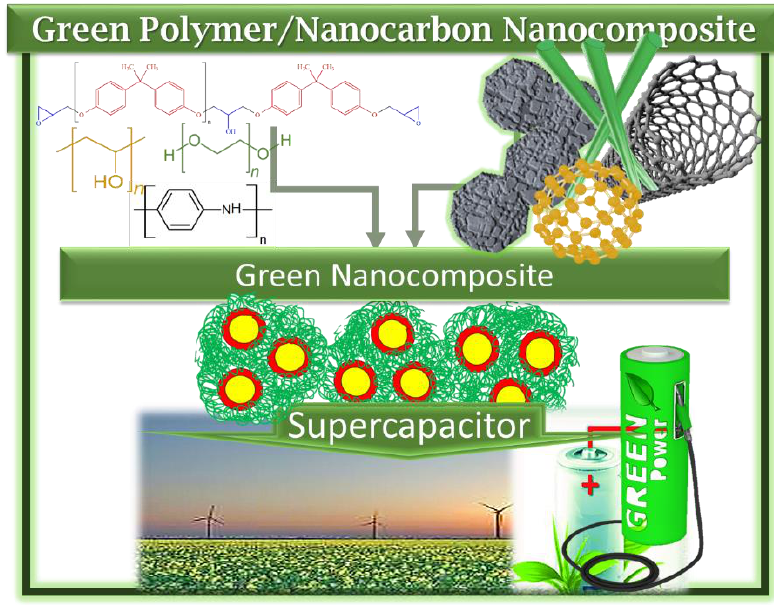
Figure 13. Green polymer/nanocarbon for supercapacitors.